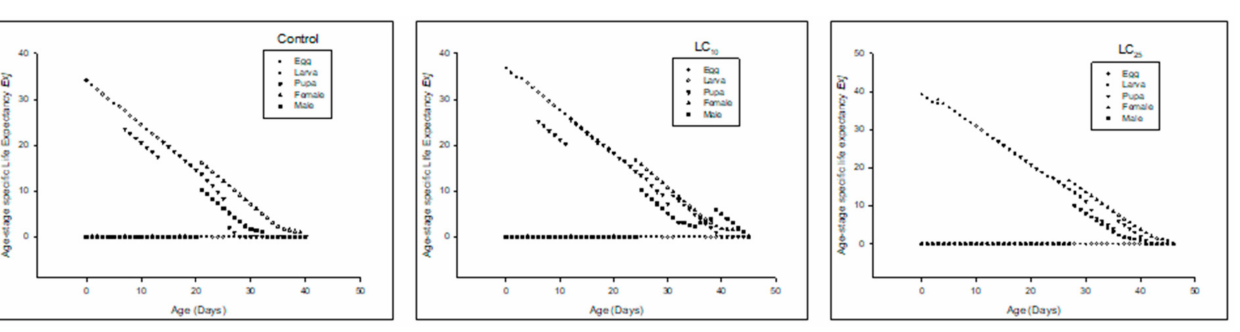
Figure 4. Age stage-specific survival rate ( s xj ) of the F 1 generation in Spodoptera frugiperda . The e xj was higher in LC 10, and LC 25 -treated insects compared to the control (Figure 5).